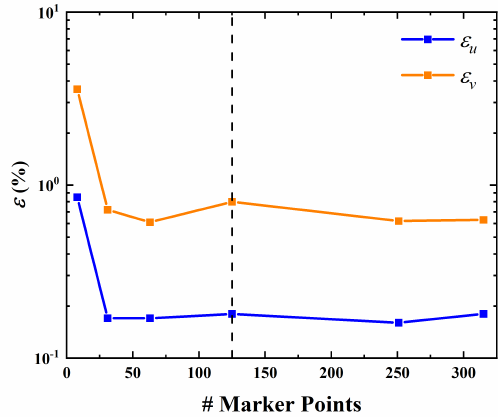
Figure 14. Influence of the number of marker points on velocity error. The dashed line denotes the place where the resolutions of marker points and collocation points are